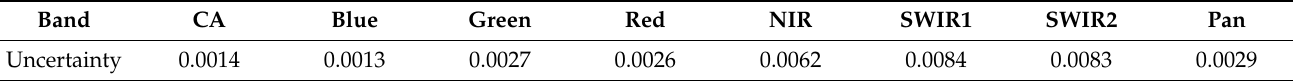
Table 13. Total uncertainty